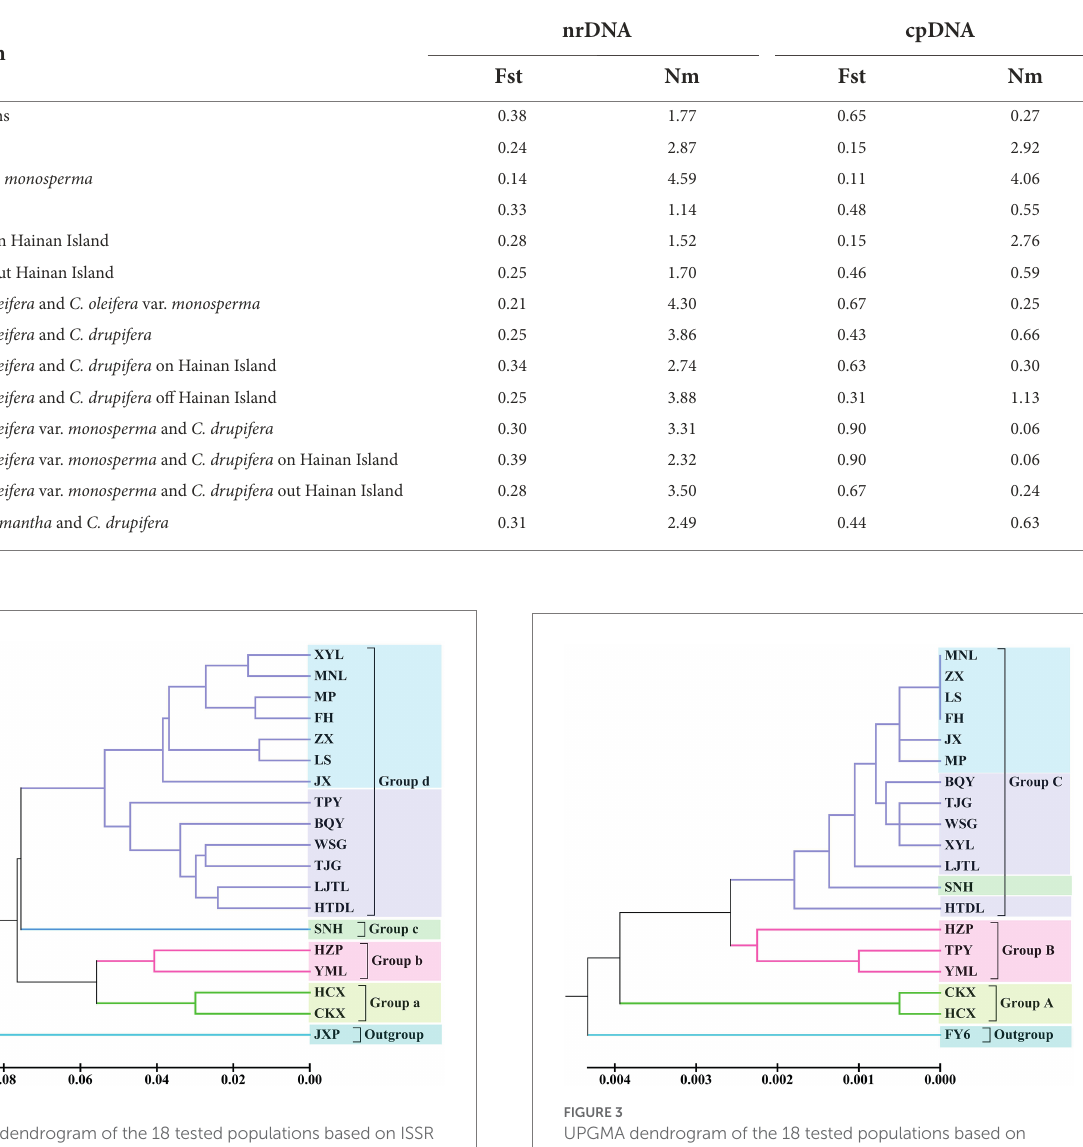
TABLE 2 Genetic differentiation coefficients among the tested